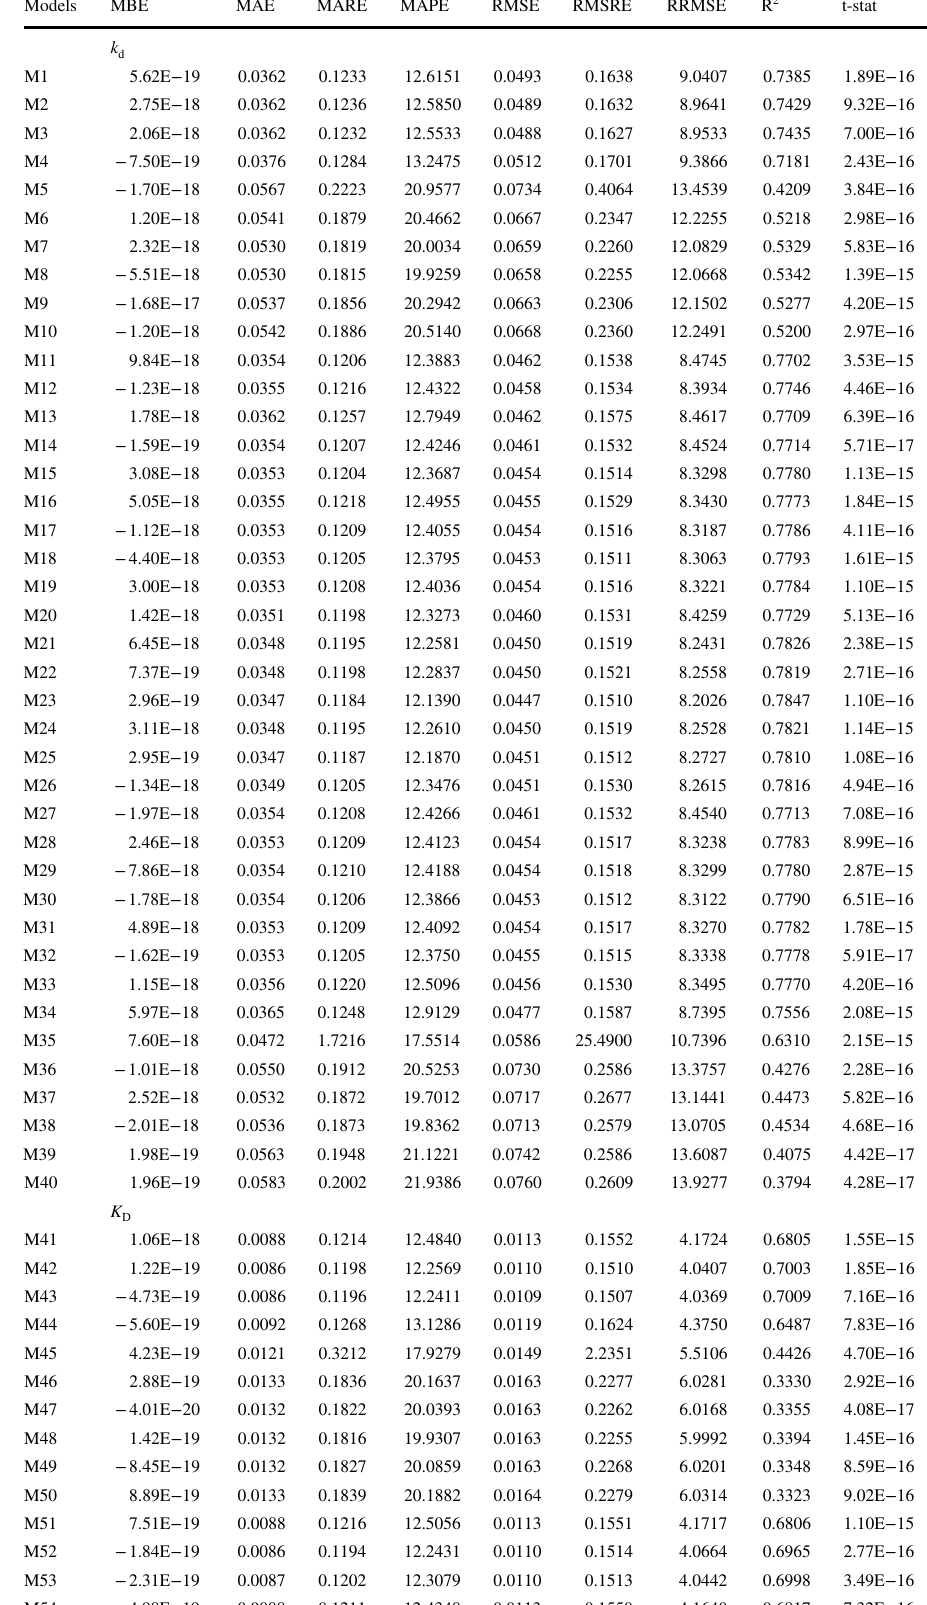
Table 4 Results of statistical indicators for all proposed